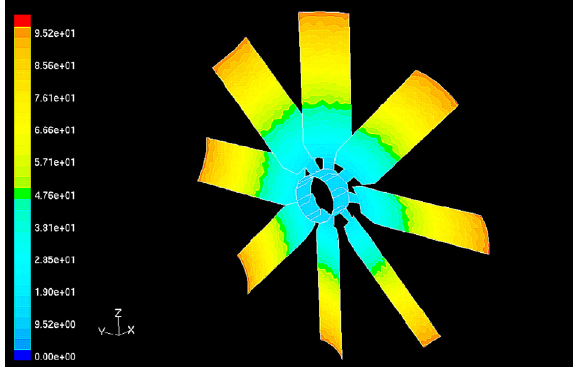
Figure 23: Contours of velocity magnitude on the pressure side with radiator (unit in